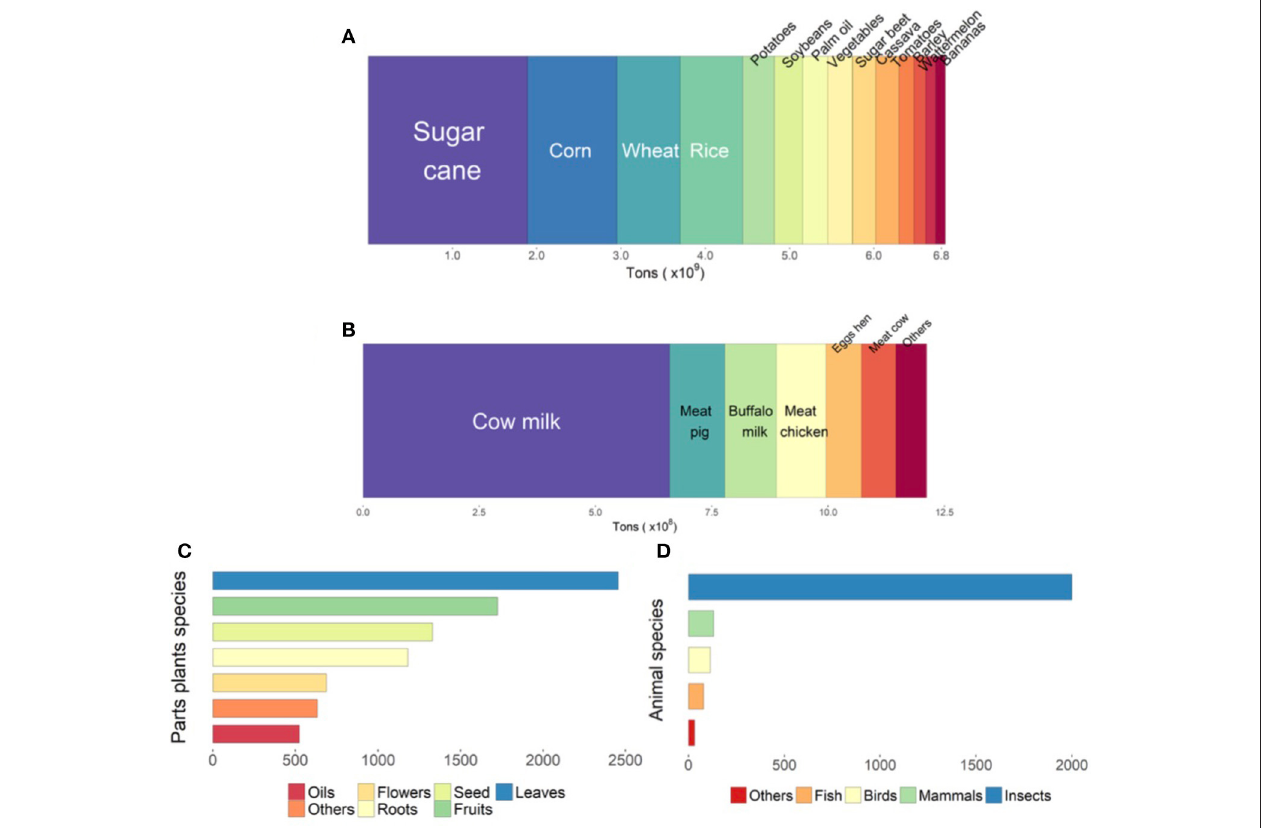
FIGURE 2 | Plants and animals making up the highest human consumption rates in 2016 and the potential species that can be consumed locally. (A) Sugarcane is the most produced agricultural product with almost 2 × 10 9 tons/year, followed by corn, wheat, and rice. (B) Cow’s milk and meat, along with pork and chicken, are currently the main animal protein sources for the human population. (C) Several plants’ parts can be used from thousands of species for human consumption, including leaves, fruits, seeds and roots (Guil and Torija, 2002; Shaheen et al., 2017). (D) Animals that could be consumed as part of the human diet, the insect group could have the highest extraction potential due to its diversity and population density (Van Huis,